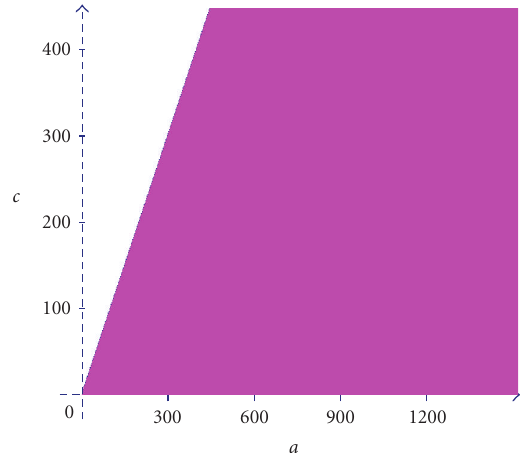
Figure 4.1 . Region of necessary and su ffi cient stability condition for (3.4): p = 0, h =